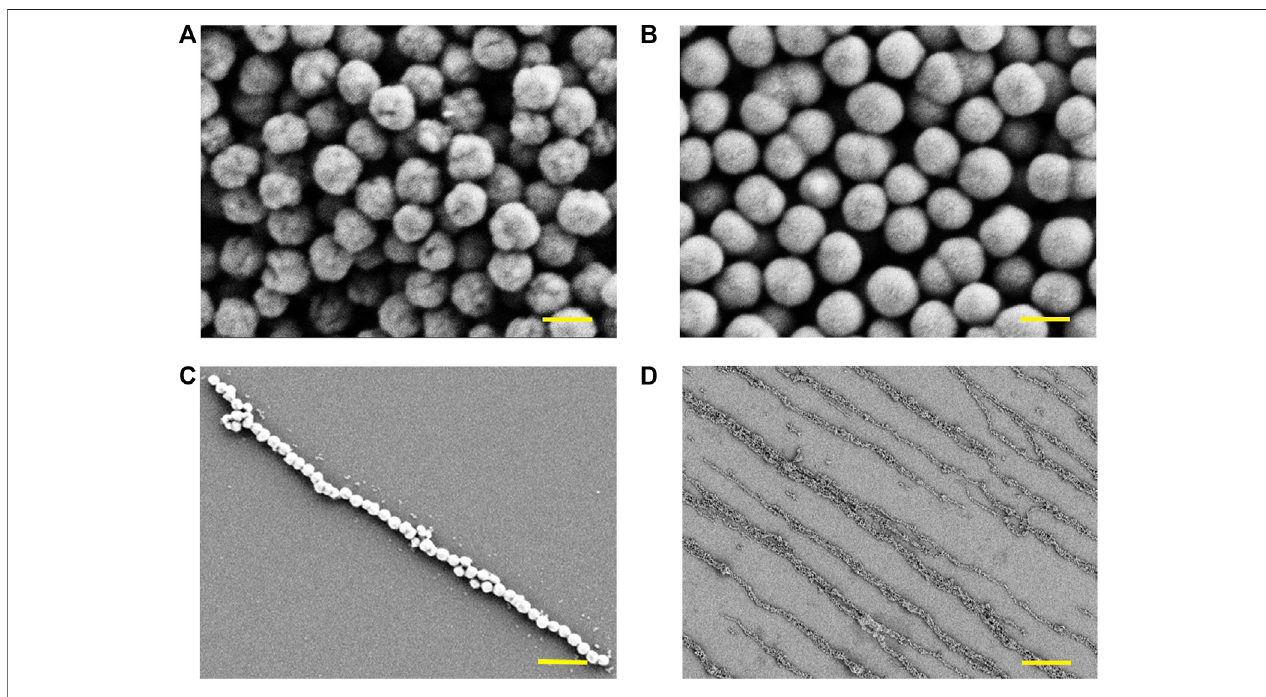
FIGURE2| Characterizationofmagneticnanomaterials. (A) Fe 3 O 4 coresofthemagneticnanoparticlesobservedbySEM,andthescalebaris200 nm. (B) Fe 3 O 4 @ SiO 2 nanoparticles observed by SEM, and the scale bar is 200 nm. (C) Representative single magnetic nanochain observed by SEM, and the scale bar is 1 μ m. (D) Overview of magnetic nanochains observed by SEM, and the scale bar is 10 μ